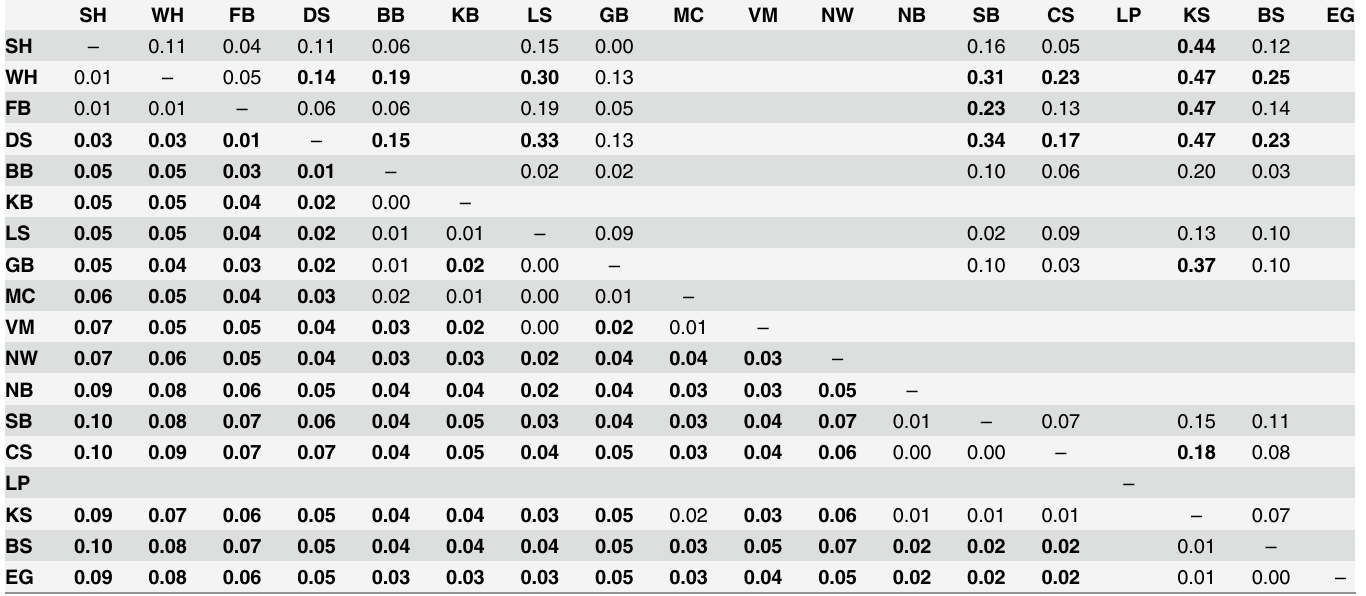
Table 2. Pairwise F ST values for nuclear microsatellites (below diagonal) and pairwise Φ ST values for mitochondrial DNA (above diagonal); signifi- cant values are bolded. MU abbreviations are as in Table 1. Solid lines demarcate the four major clusters discovered by Paetkau et al ., 1999 [4], which cor- respond to our S TRUCTURE results for K = 4. From left to right, these are: the Hudson Complex, the Canadian Arctic Archipelago, Norwegian Bay, and the Polar Basin. Dotted lines denote the west – east clusters within the Basin and the Archipelago detected by K -means clustering in G ENO D IVE . These six clusters include additional east – west substructure within the Archipelago and within the Polar Basin. DS is an admixture zone showing affinity for both Hudson Com- plex and the Archipelago, with southern samples tending to belong to the Hudson Complex cluster and northern samples tending to belong to the Eastern Archipelago cluster. LP has been excluded from all comparisons because it deviates significantly from Hardy – Weinberg equilibrium. For mitochondrial DNA, MC, VM, and NW were omitted because sample sizes were too small (i.e., N (cid:1) 3, k = 1) to accurately estimate haplotype